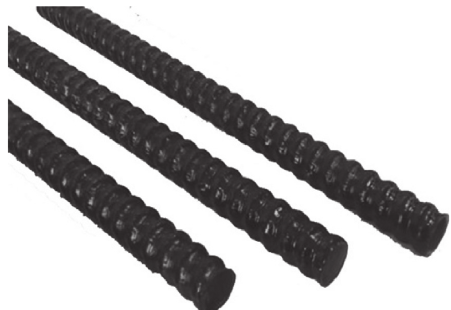
Figure 3: Glass fiber-reinforced plastic (GFRP) rock